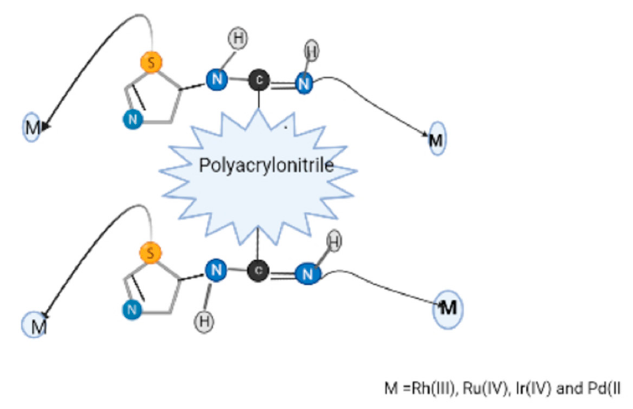
Figure 15. Possible sorption mechanism of different metal ions by poly(acrylonitrile-2-amino-2-thiazoline) resin. The adsorption by modified adsorbent was more selective for Pd 2+ and Rh 3+ in acidic conditions.